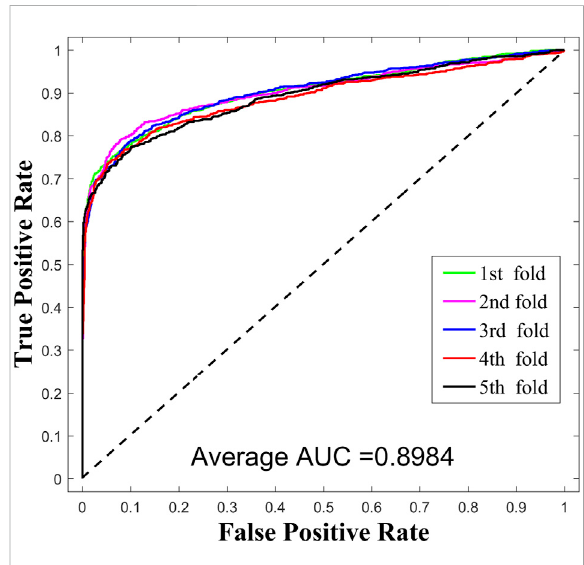
FIGURE 3 Performance results of SPCMLMI using the bilayer network.